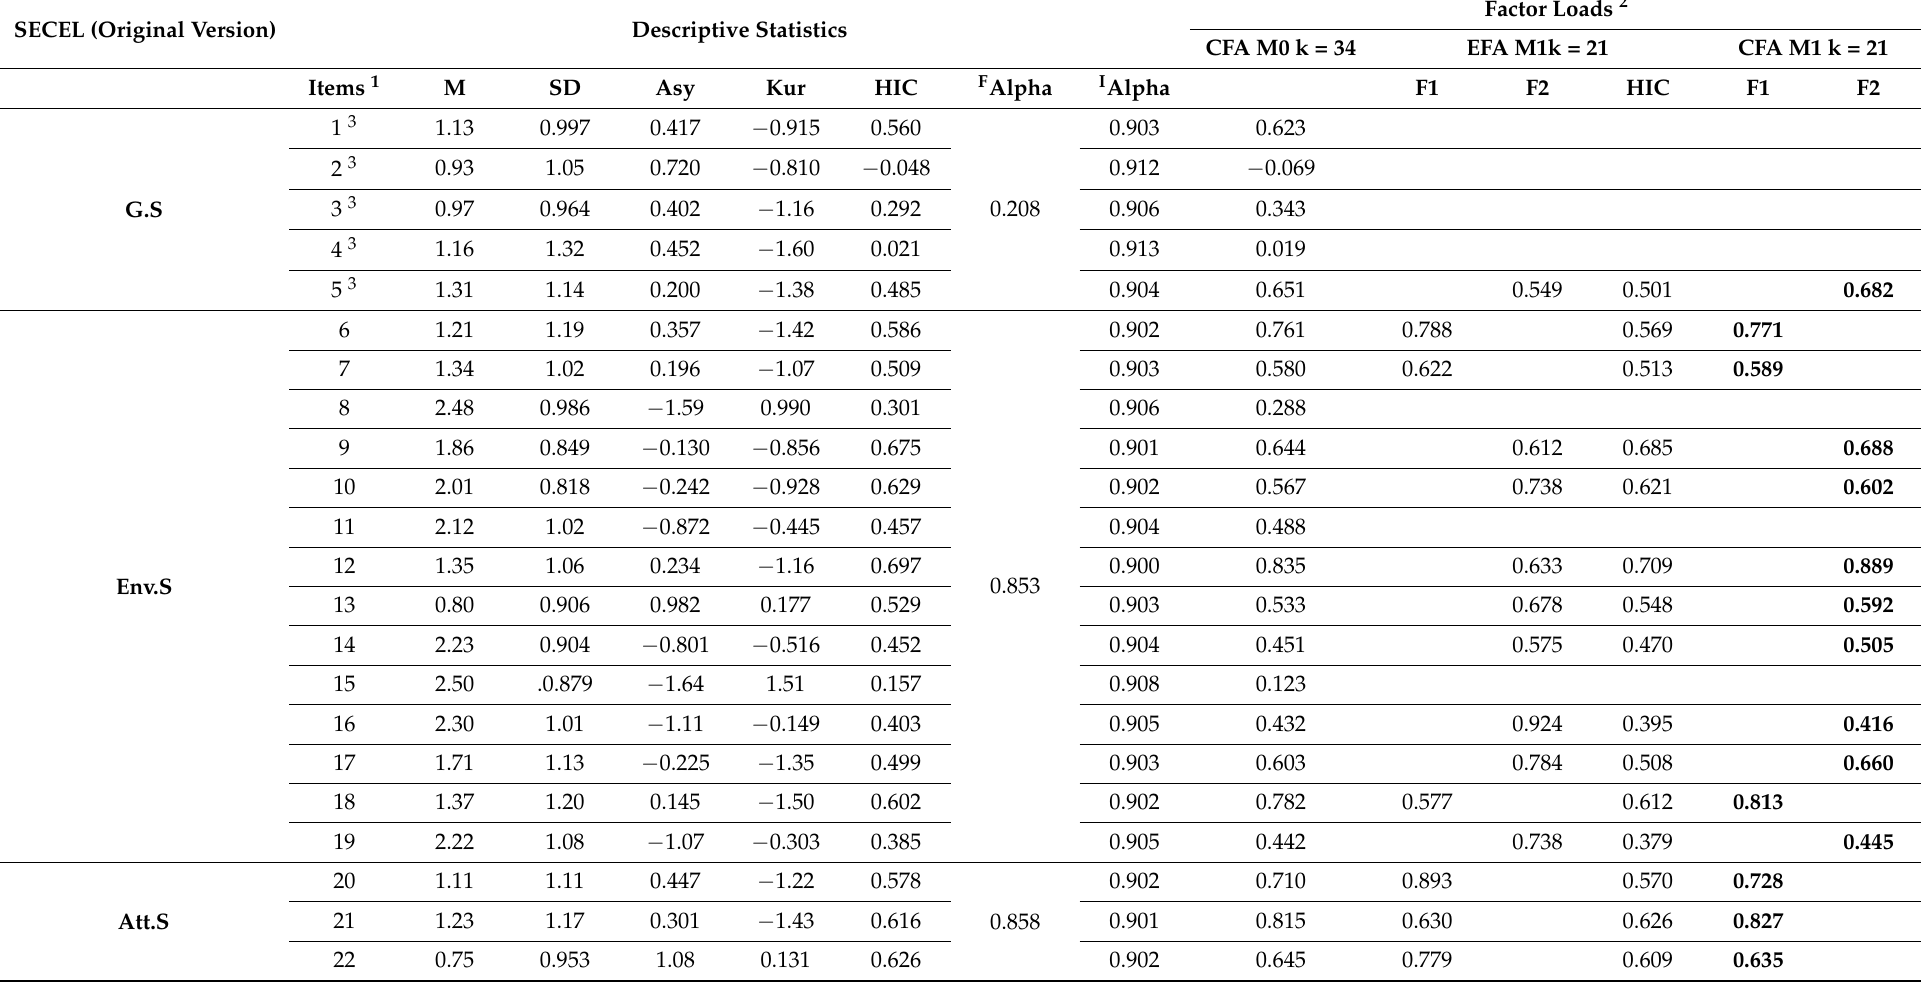
Table 5. Descriptive statistics of the items of the original SECEL questionnaire in the adaptation for a sample of Spanish laryngectomized patients. The factor loadings of the original model (M0) and of the model M1 (EFA and CFA) are shown once the items have been